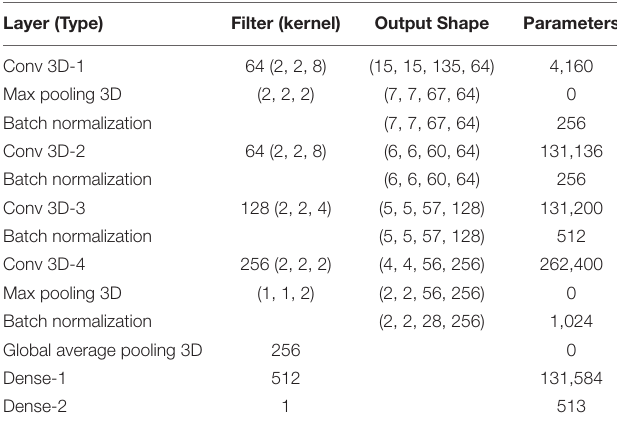
TABLE 2 | 3D CNN model